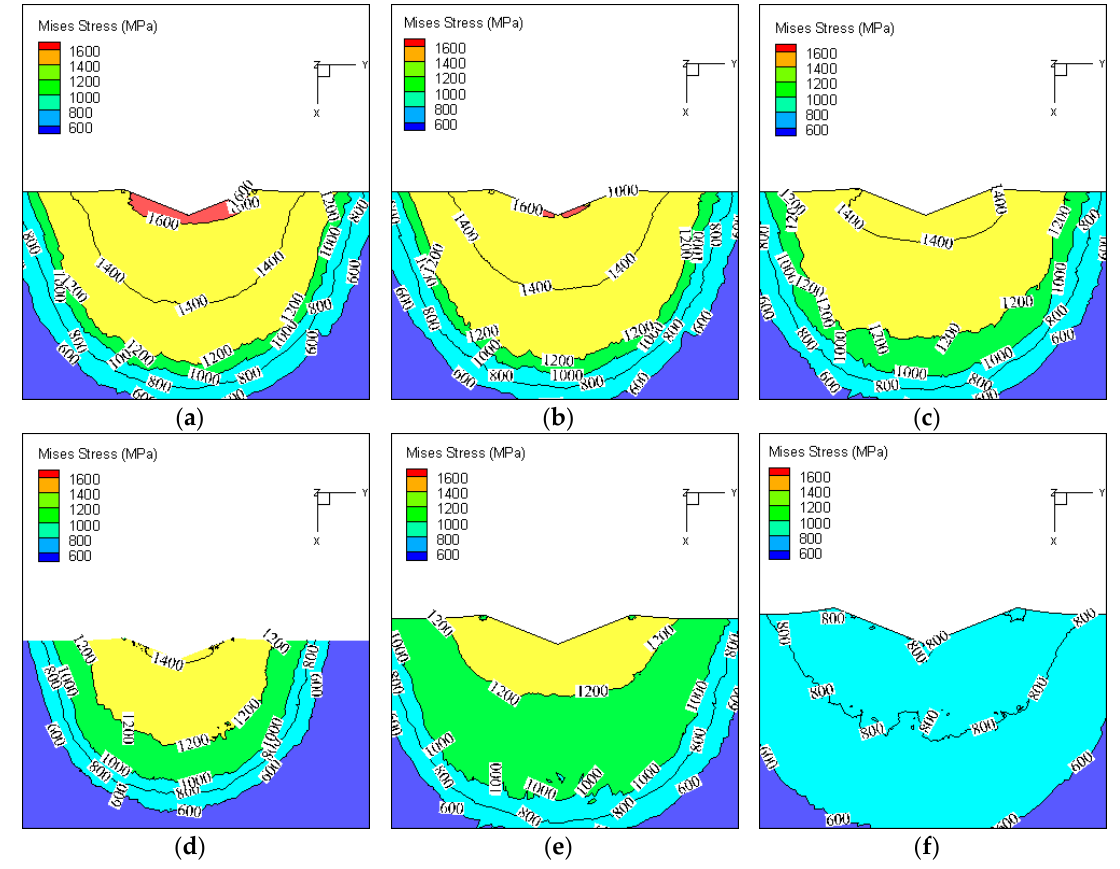
Figure 18. Stress contour of indentation section under different test temperatures (Load = 10 kg). ( a ) Temperature = 20 °C; ( b ) Temperature = 200 °C; ( c ) Temperature = 400 °C; ( d ) Temperature = 500 °C; ( e ) Temperature = 600 °C; ( f ) Temperature = 800 °C.